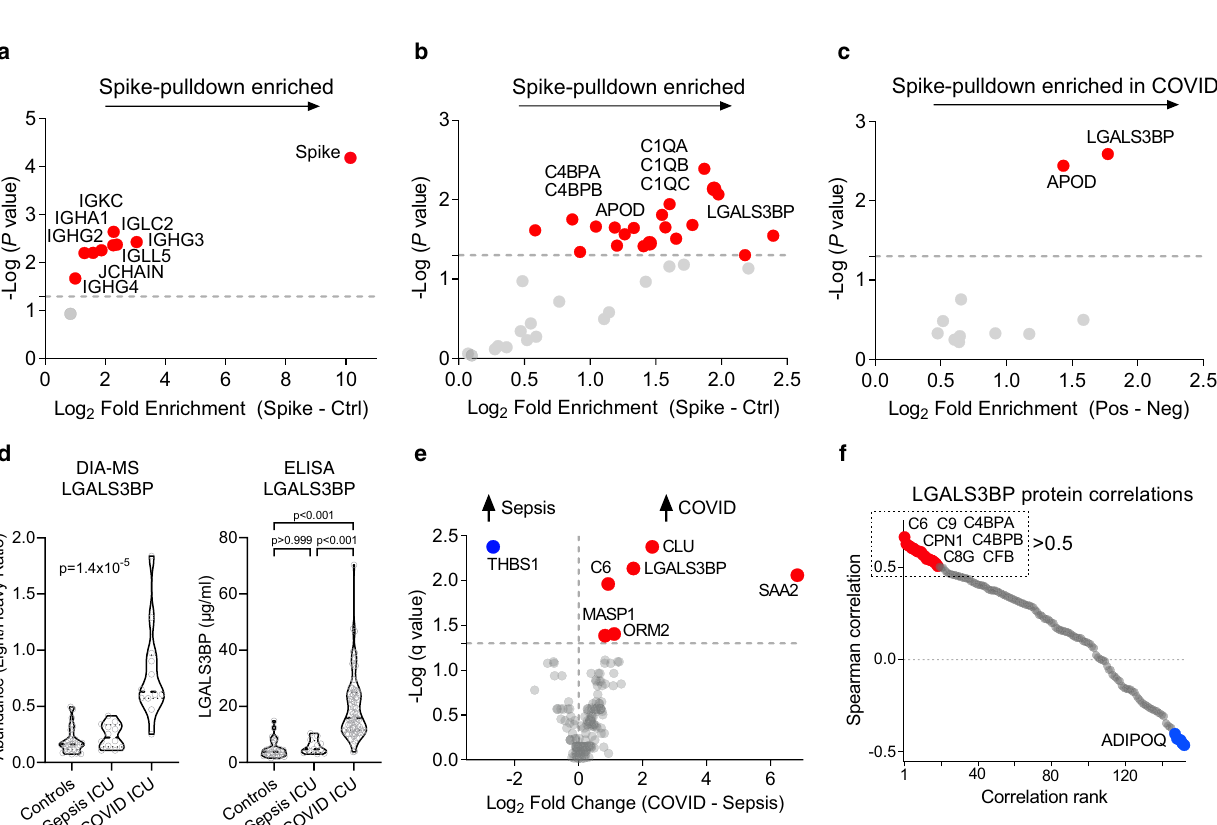
Fig. 7 LGALS3BP interacts with SARS-CoV-2 spike glycoprotein. a Magnetic bead-based af fi nity isolation of binding partners using His-tagged SARS- CoV-2 spike glycoprotein as a bait for proteins in SARS-CoV-2-positive patient plasma ( n = 8). Volcano plot depicting signi fi cantly enriched constant chains of immunoglobulins. b Volcano plot depicting signi fi cantly enriched non-immunoglobulin proteins ( n = 8). c Comparison of SARS-CoV-2 spike glycoprotein pulldown using plasma from COVID-19 ICU patients ( n = 8) and non-COVID-19 patients ( n = 3). Signi fi cance was determined by paired Student ’ s t tests for ( a ) and ( b ) and unpaired Student ’ s t tests for ( c ). d LGALS3BP levels across three patient cohorts as determined by DIA-MS or ELISA: control patients before undergoing elective cardiac surgery ( n = 30), pre-pandemic sepsis ICU patients ( n = 12) and COVID-19 ICU patients ( n = 74). Kruskal – Wallis and Dunn ’ s multiple comparisons tests were used to determine statistical signi fi cance. e Volcano plot representing protein changes between baseline plasma samples from patients in ICU with either sepsis ( n = 12) or COVID-19 ( n = 12). Signi fi cance was determined through the Mann – Whitney U test with Benjamini-Hochberg ’ s FDR correction. f Plasma proteins correlating to LGALS3BP after age and sex corrections in COVID-19 ICU patients ( n = 12) are highlighted by a Spearman correlation matrix across the proteomic dataset. Proteins with a Spearman correlation coef fi cient greater than 0.5 were used for gene ontology pathway enrichment analysis (Supplementary Fig. 10). All statistical analyses are 28-day ICU mortality (Fig. 3d). Systemic complement activation dysfunction following SARS-CoV infection 57 . It was recently has been associated with respiratory failure in hospitalized reported 58 that circulating complement factors are high before seroconversion, while markers of systemic complement activation COVID-19 patients 55 , and complement de fi ciencies appear to decrease after seroconversion, although this particular study did have protective effects on COVID-19-associated morbidity and not include patients admitted to ICU with life-threatening mortality 56 . Similarly, C3 de fi cient mice developed less respiratory